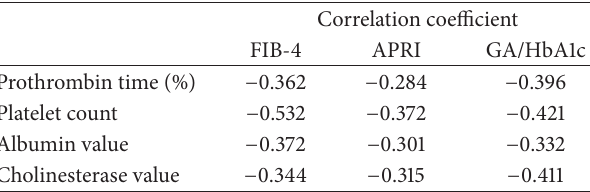
Table 2: The correlations of the three biomarkers with liver function